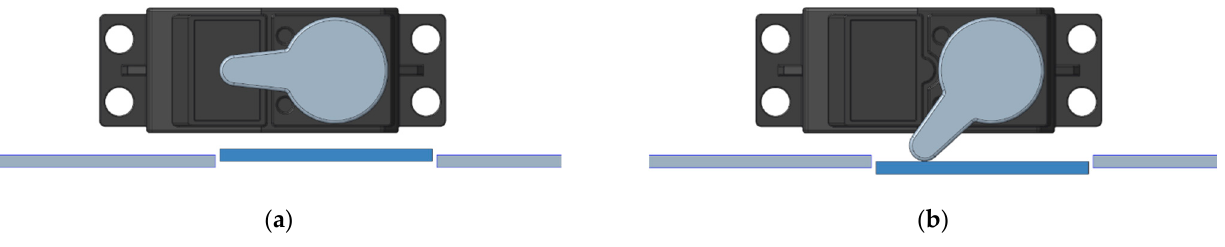
Figure 2. Push button activation with servomotors: ( a ) button (blue part) released; ( b ) button (blue part) pressed.